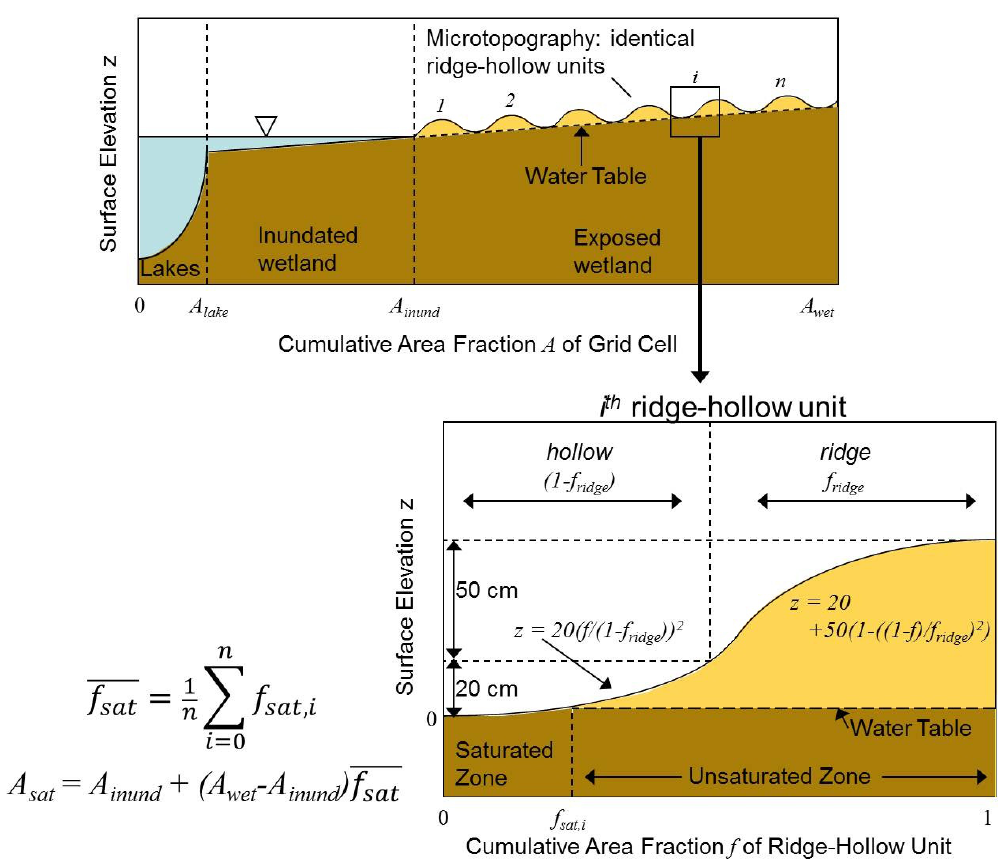
Fig. 2. Components of lake–wetland system considered in this study.